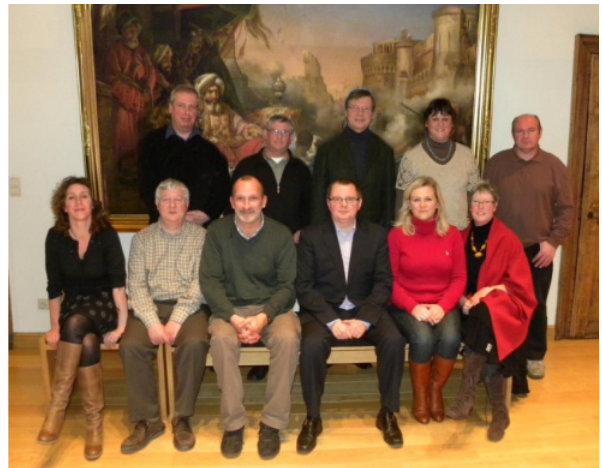
Figure 1. Cultuurraad Geraardsbergen [Untitled Photograph] From Wissels: Handboek sociaal-cultureel werken met volwassenen (p. 486), by F. Cockx, H. De Blende, G. Gehre, G. Van den Eeckhaut and G. Verschelden (Eds.), 2011, Brussels: SoCiuS. Permission to use the picture from Cultuurraad